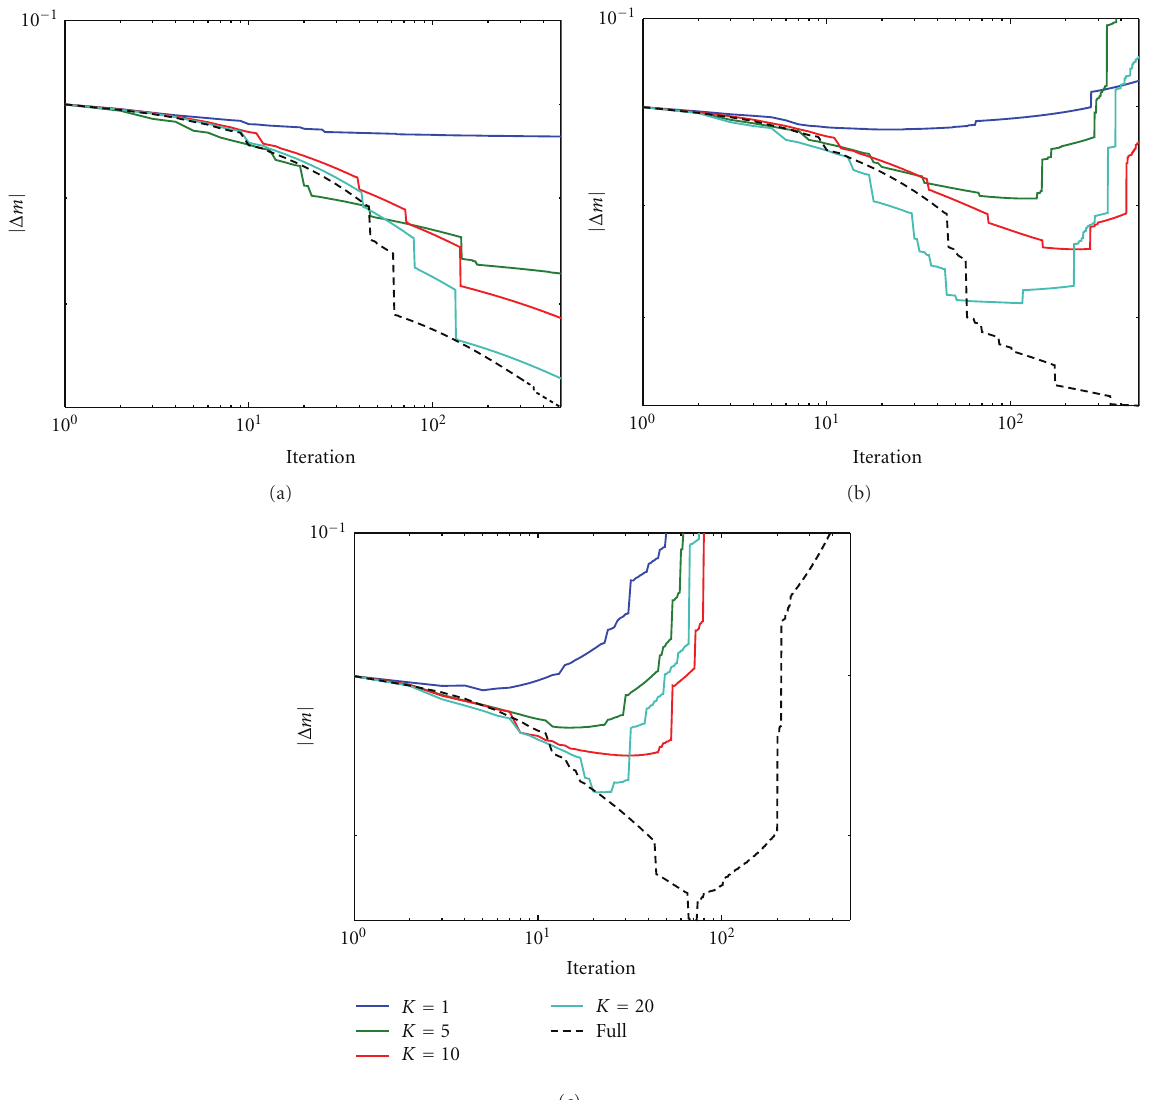
Figure 8: Error between the inverted and true model for the SAA approach with various batch sizes and the full problem, (a) without noise, (b) with noise (SNR = 20dB), and (c) with noise (SNR = 10 dB). On noiseless data, we achieve a qualitatively comparable result with K =